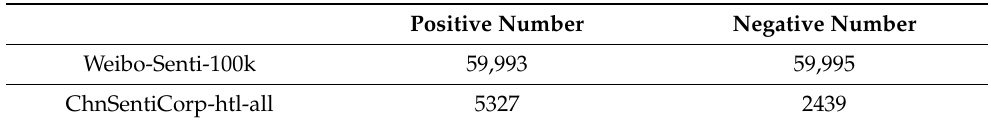
Table 1. Stastics of Weibo-Senti-100k and